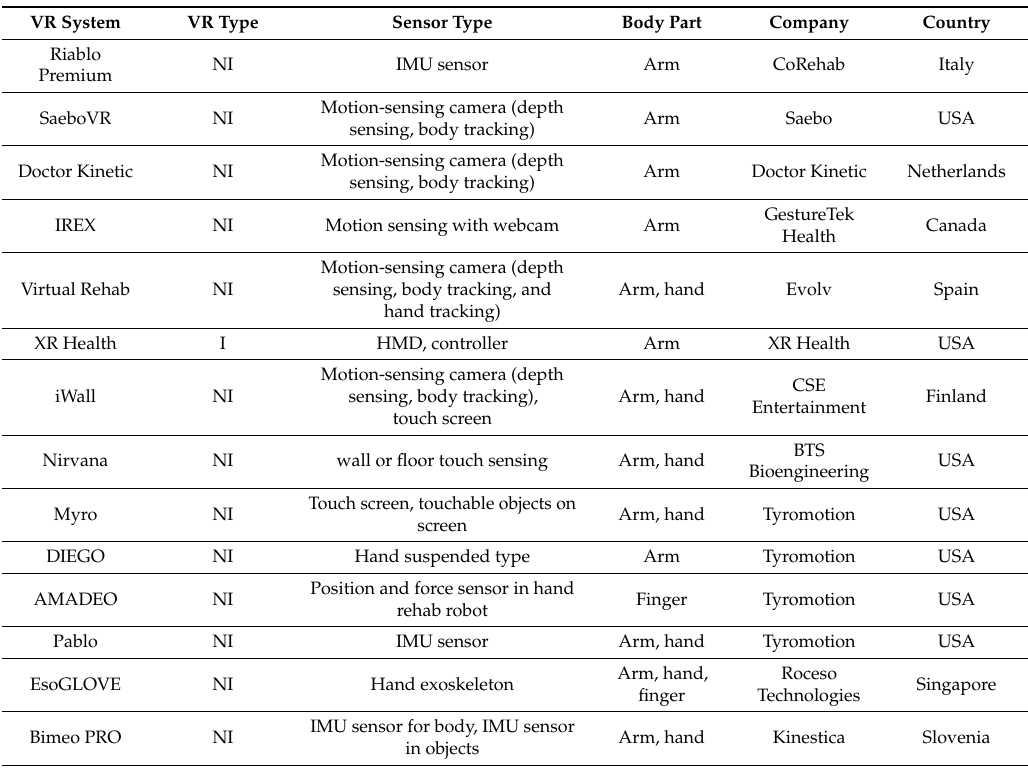
Table 2. Commercialized VR systems custom ‐ built for upper limb rehabilitation.